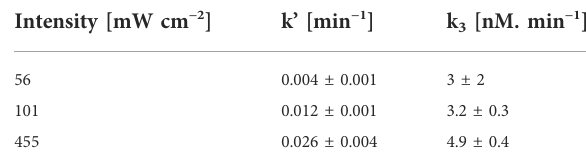
TABLE 1 Parameter values for the model fi tted to the experimental formazan formation